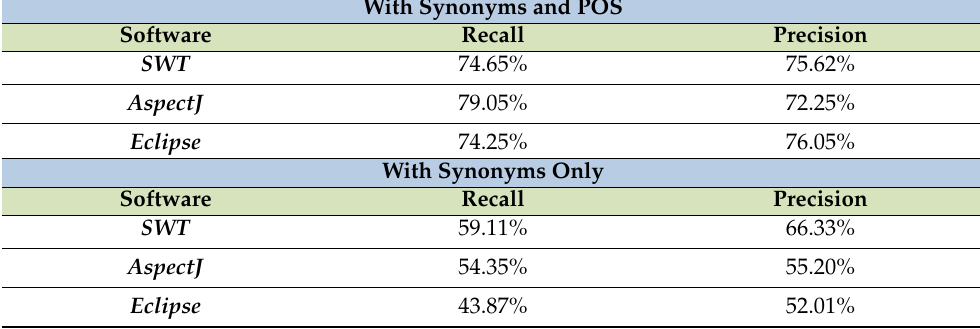
Table 4. Recall and precision for synonyms using POS.